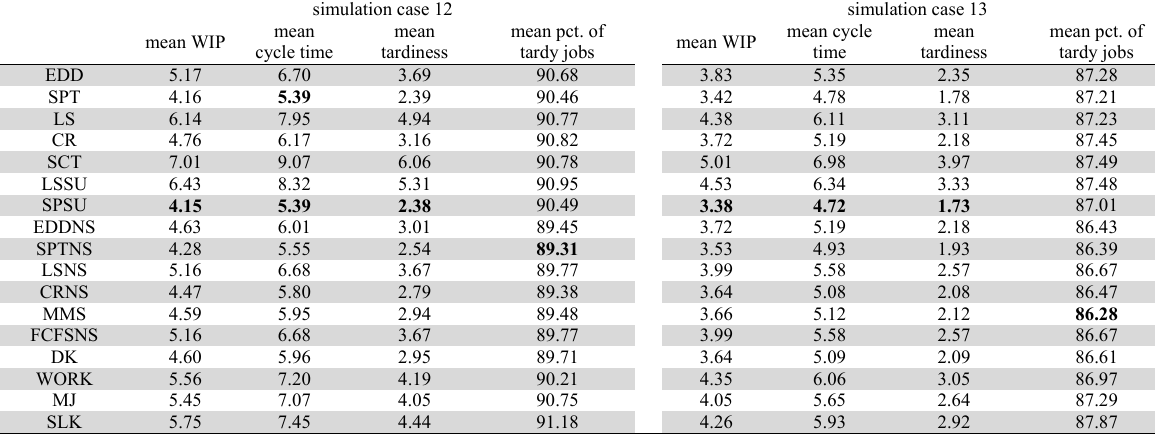
Results for simulation cases 12 and 13